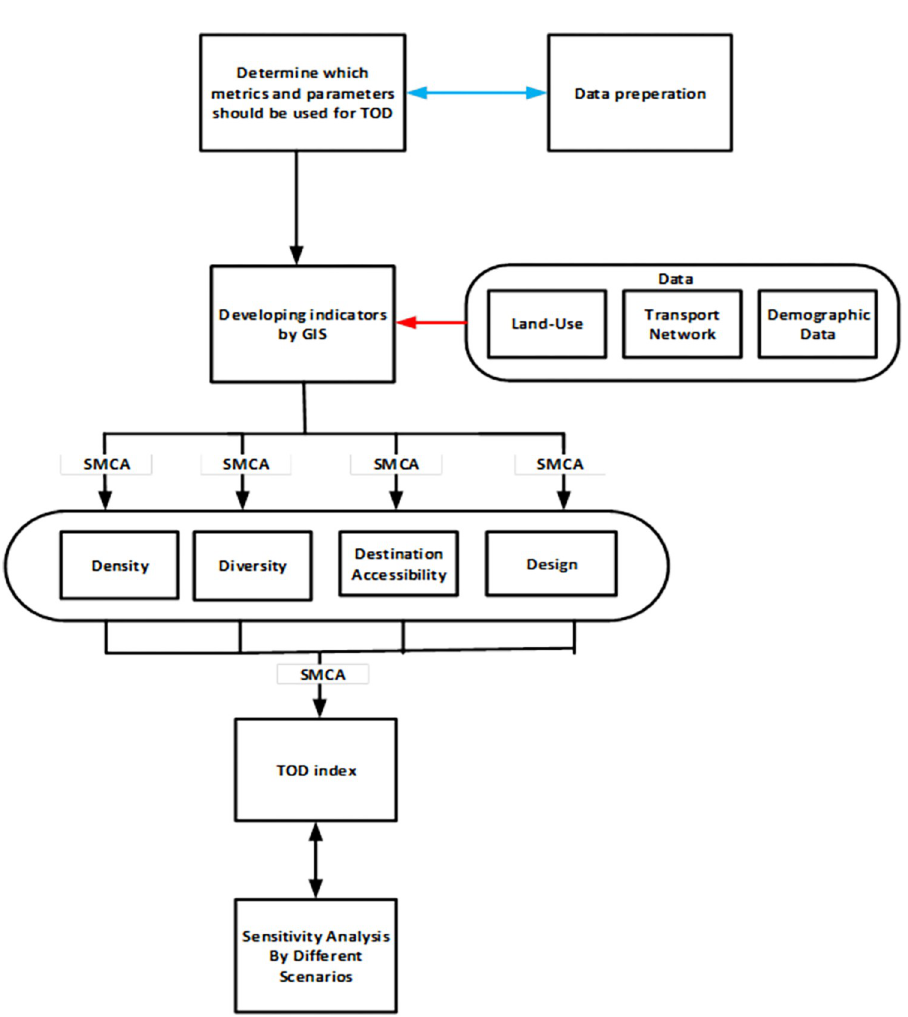
Fig 4. SMCA analysis framework for TOD index